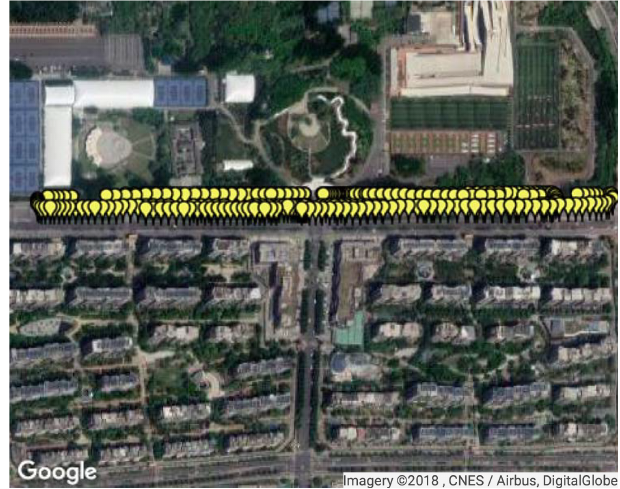
Figure 16. The second test site and test points. The yellow markers on the map denote the test points. Two segments were chosen as the areas with satellite loss at Site 2, where available satellite number was restricted to two. Test points at the two segments are shown on satellite map as the red points in Figure 17. Visible satellite numbers at the sampling points before and after manual satellite signal shielding are shown as Figure 18. In the figure, we can see that before manual satellite loss there were more than five available satellite at most test points. Restriction on satellite number led to changes in GDOP, as shown in Figure 19. When signals from some satellites were shielded, GDOP increased instantly. The inputs and output of our fuzzy inference system are shown in Figure 20. In the figure, we can see that the integration modes at points without satellite loss were mostly GPS-only and at points with satellite loss remained the proposed GPS + DTMB + FM